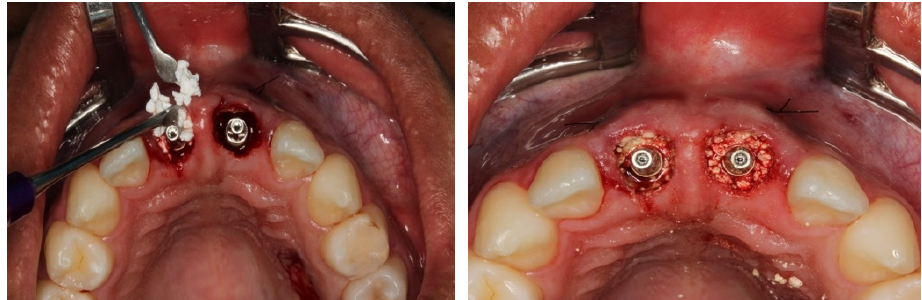
Figure 10. Filling of the gaps with the nano-biomaterial (Blue Bone ® ).